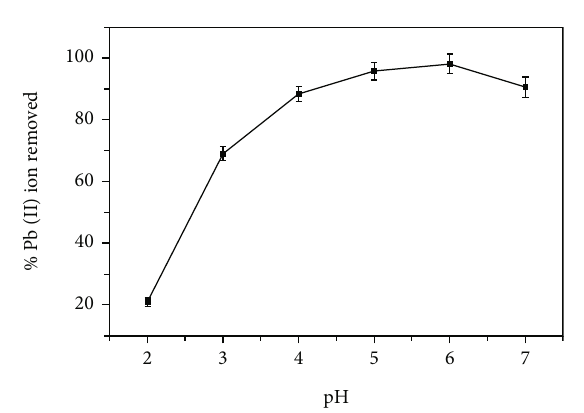
Figure 7: E ff ect of pH on adsorption behavior of Pb 2+ at constant lead (II) ion concentration of 100mg/L mixing speed of 300 rpm, temperature of 25 ° C, contact time of 60 min, and biosorbent dosage of 0.5g/L.